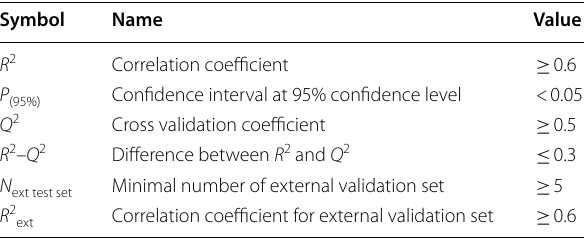
Table 2 Standard minimum proposed value used to assess a quantifiable QSAR